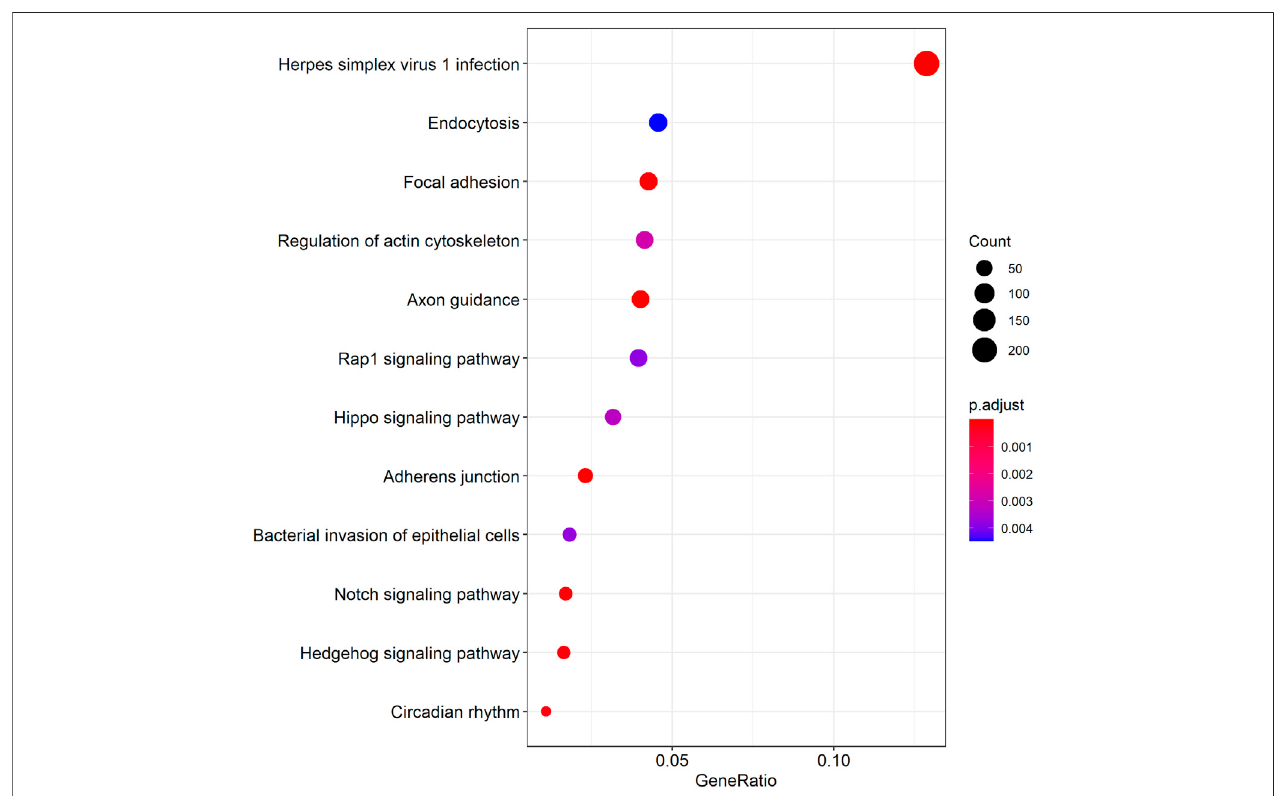
FIGURE 5 | KEGG analysis of FOXG1-AS1 target genes. Note: The target genes of lncRNAs were identi fi ed from Pearson ’ s correlation analysis (|correlation coef fi cient| > 0.4 and p < 0.001), KEGG analysis were performed in “ clusterPro fi ler ” and “ DOSE ” of R software to generated these functional pathways.